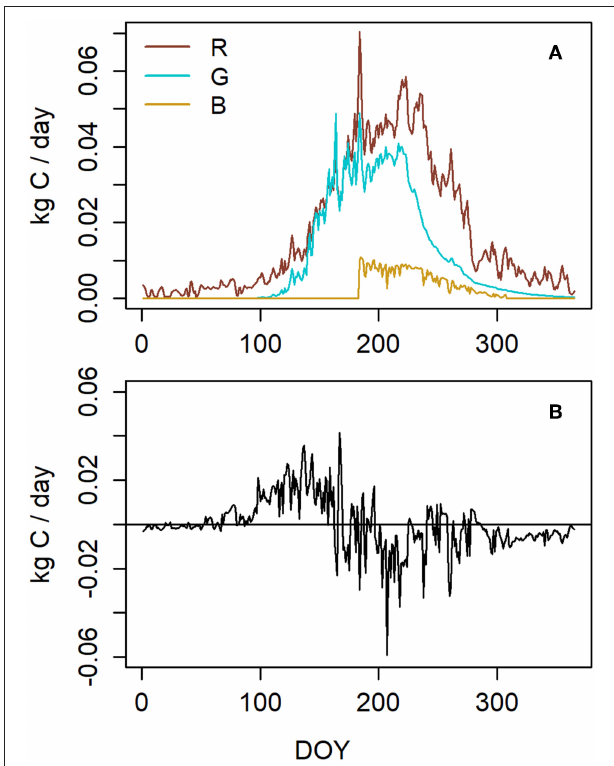
FIGURE 5 | (A) Modeled carbon sinks. R stands for respiration, G for growth, and B for the allocation to belowground symbionts. G and R include growth and respiration of the whole tree, i.e., needles, stem, and roots. (B) The difference between photosynthesis and carbon consumption in a Scots pine belonging to the size class 2 ( Table 1 ) at our measuring site in